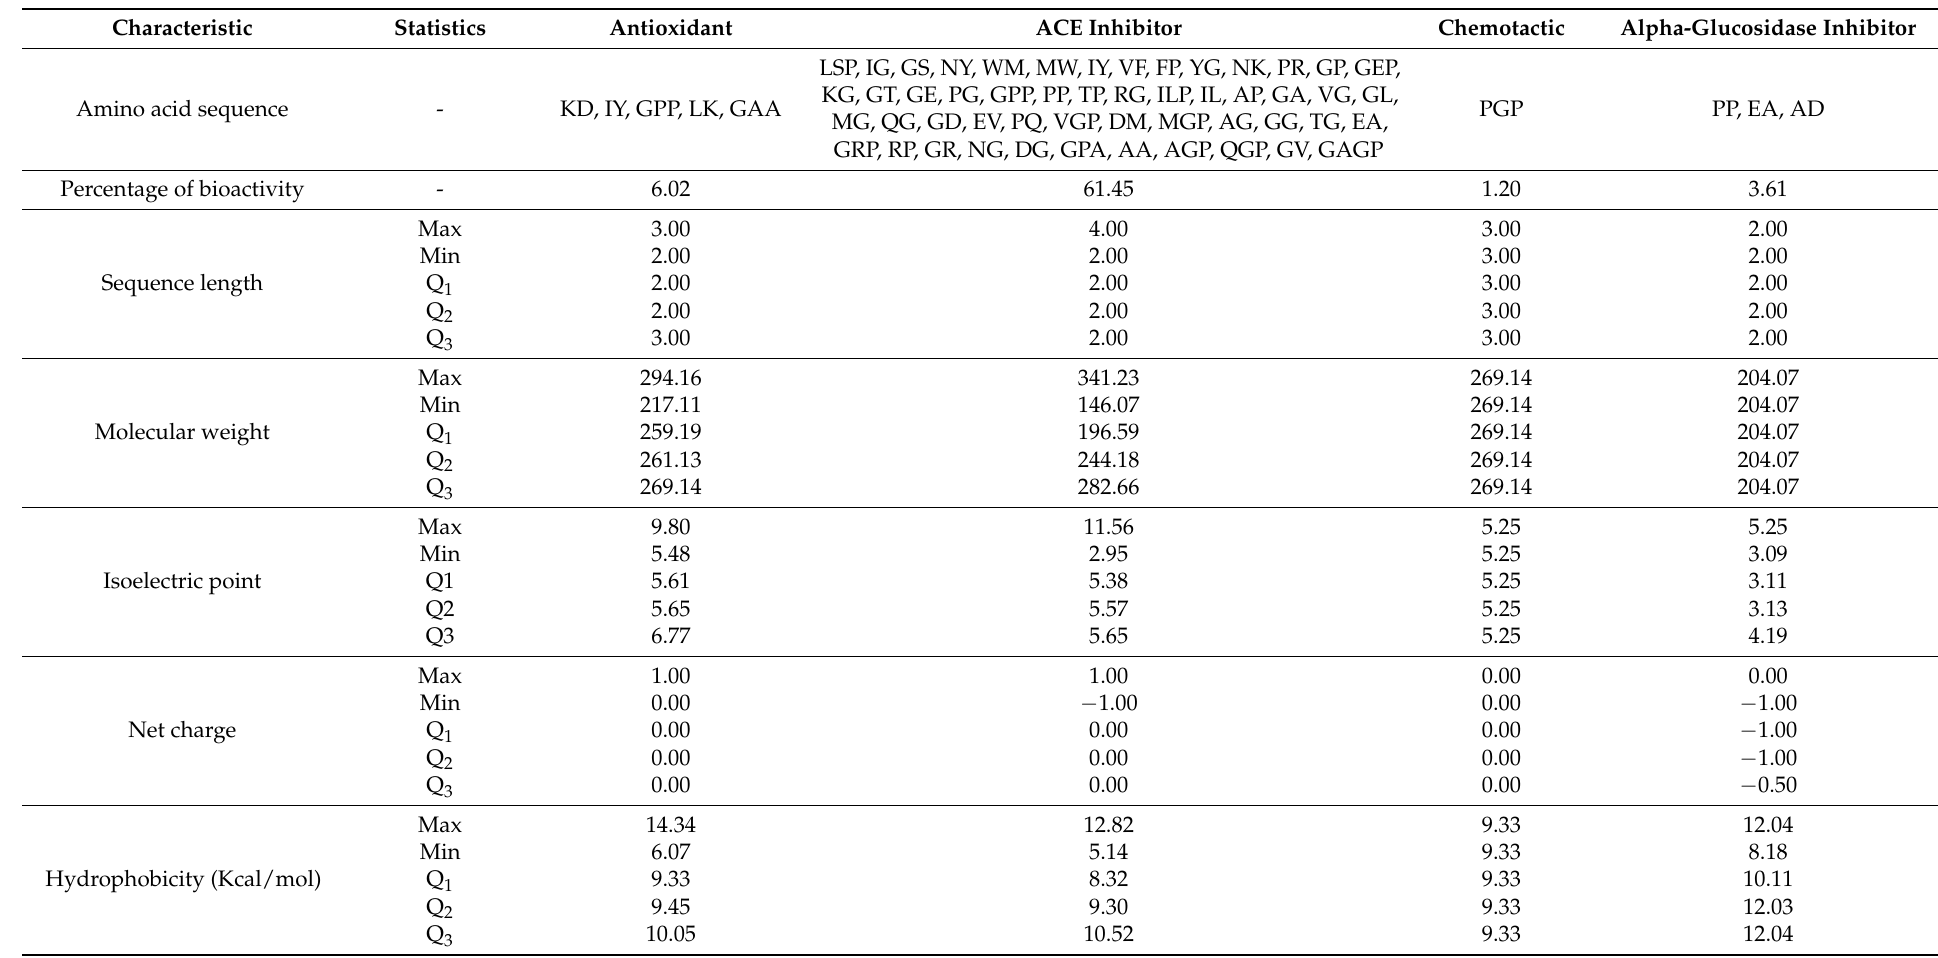
Table 5. The characteristics of the bioactive peptides in the PPS fraction of <3